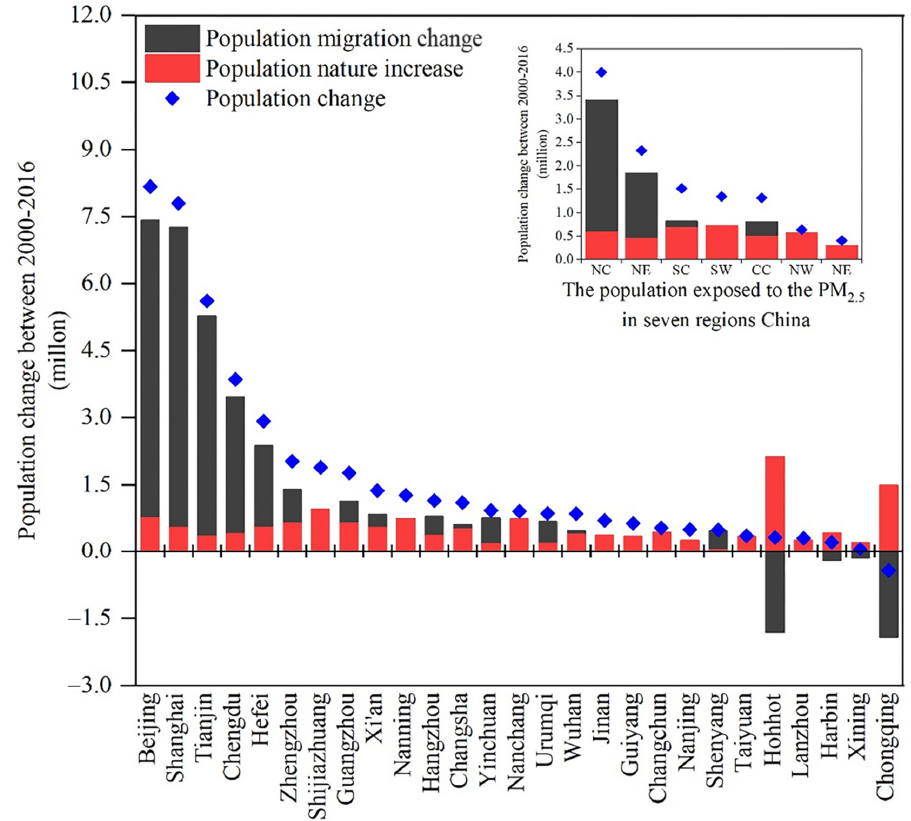
Figure 4. The contributions of migration and natural increase in the population exposed to PM 2.5 pollution during 2000 – 2016. pollution during